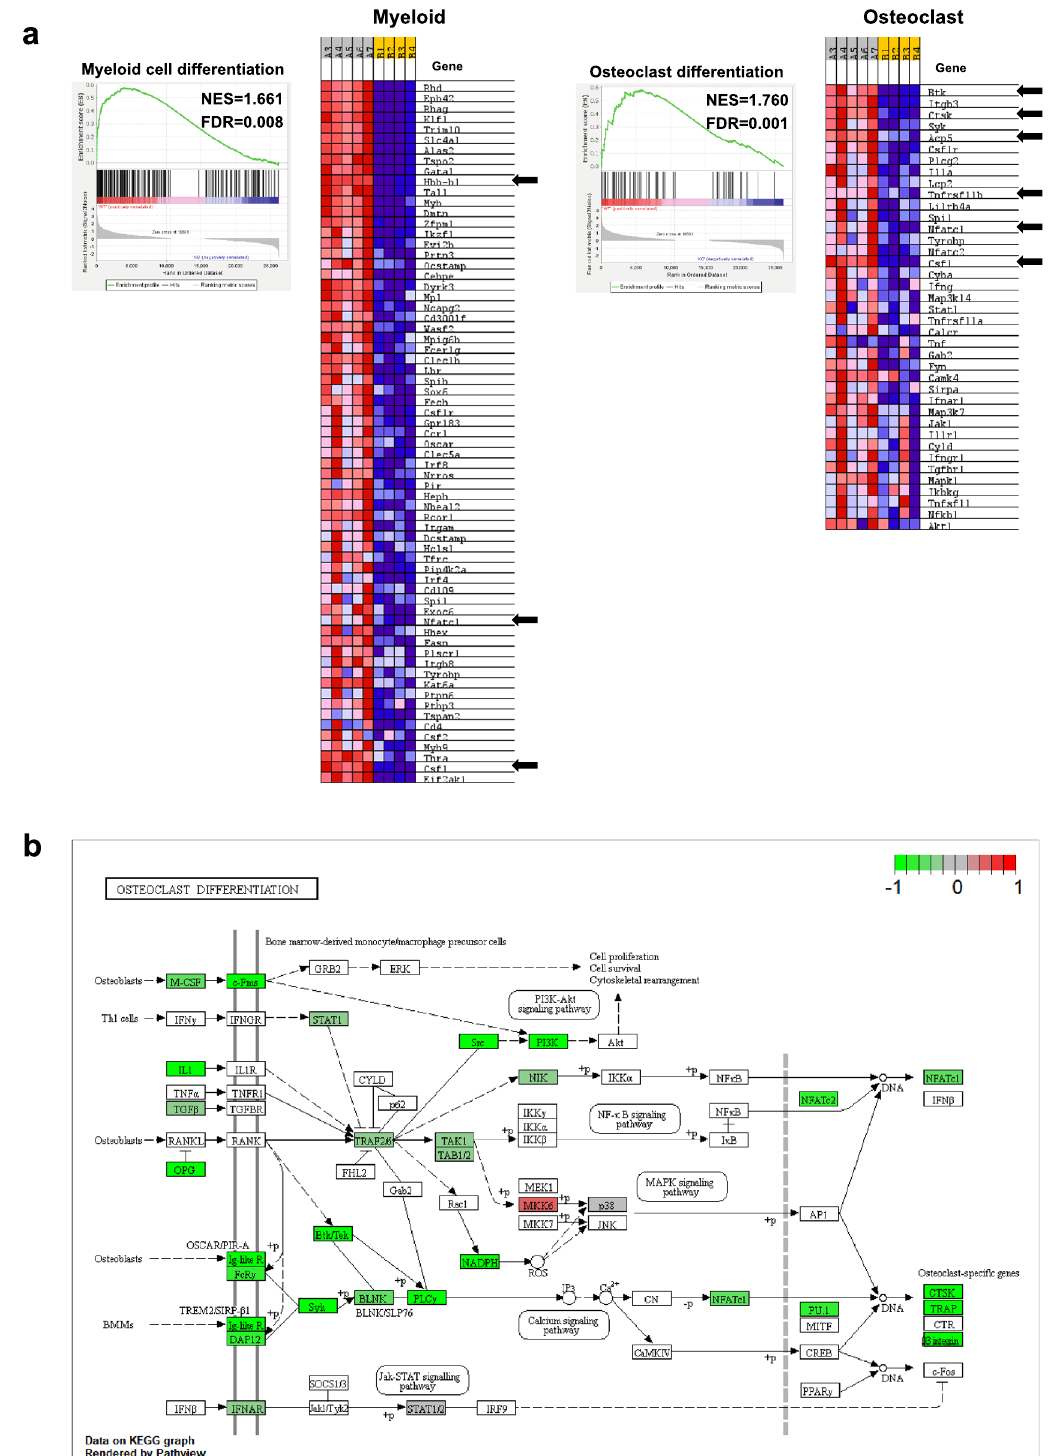
Figure 5. Downregulated genes in bone cells from FcγRIIB -/- mice associated with osteoclast and myeloid cell differentiation. ( a ) GSEA identified downregulated DEGs in osteoclast (right) and myeloid cell differentiation (left). Heatmap indicating that osteoclast- and myeloid-related genes were differentially expressed in bone cells from FcγRIIB -/- mice compared to WT controls with FDR-adjusted p < 0.05 as a cutoff. Red and blue represent up and downregulated genes, respectively. Arrows indicate 6 osteoclast and 3 myeloid genes that were validated using qPCR. NES; normalized enrichment score, and FDR; false discovery rate. ( b ) Downregulated DEGs are associated with osteoclast differentiation by KEGG pathway